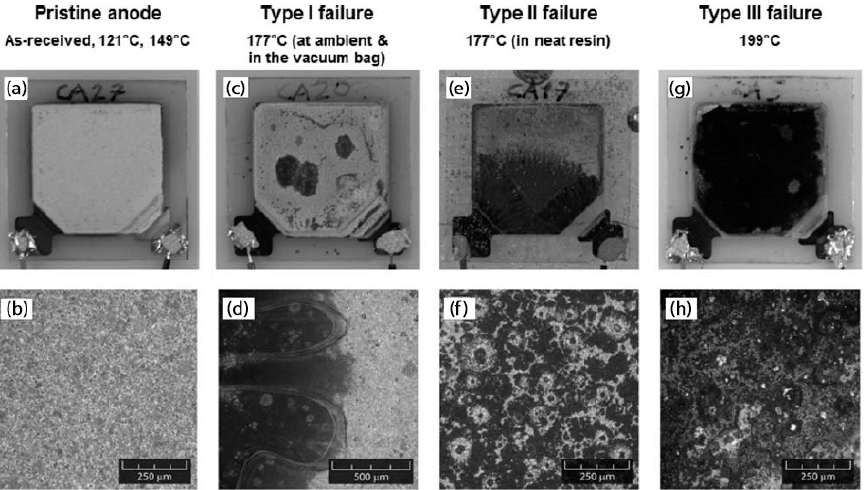
Figure 6. Battery thermally tested and surface magnification showing: ( a – b ) no degradation, ( c – d ) gray spots, ( e – f ) sealing/anode reactions and ( g – h ) melted anode [25].